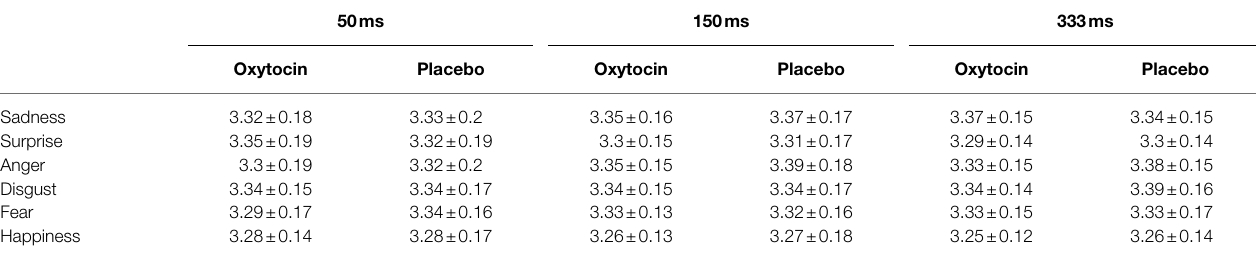
TABLE 4 | The RT (log transformed) of standardized micro-expression recognition task in Study 2 ( M ± SD